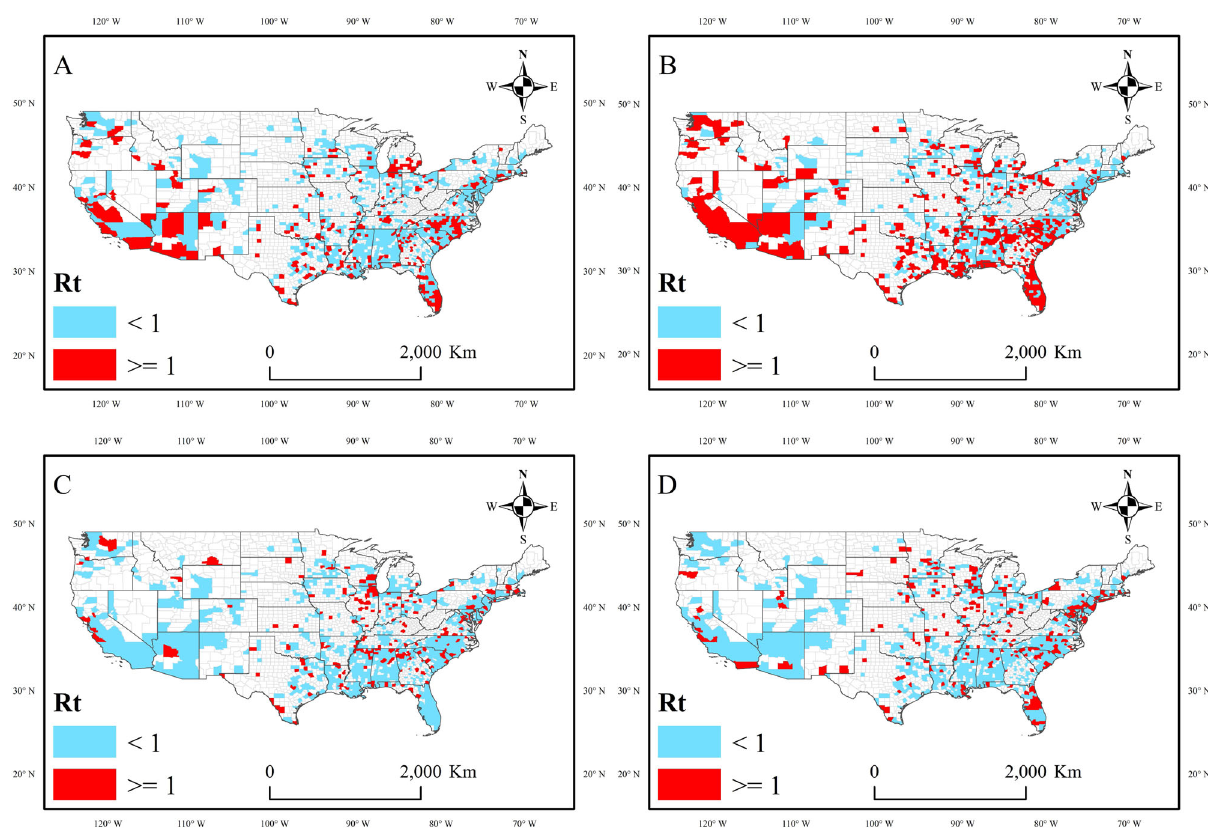
Fig. 2 Spatial distribution of Rt values by county at four time points. We take 1 as the standard value and divide those with an R t ≥ 1 into one category (marked in red) and those with an R t < 1 into another category (marked in blue). A June 1, 2020, B July 1, 2020, C August 1, 2020, and D August 31, 2020. White areas indicate counties where no data are